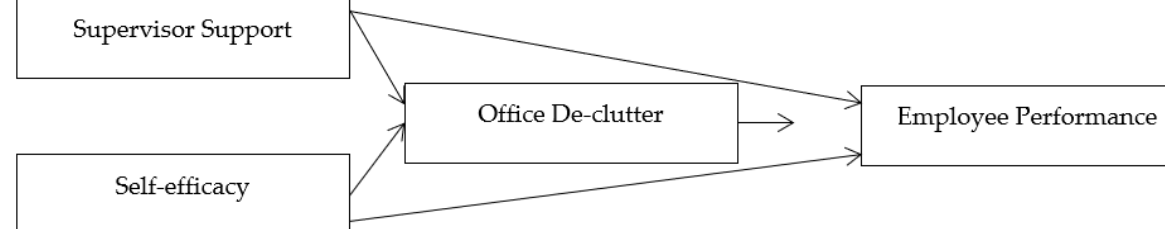
Figure 1. Research Framework.